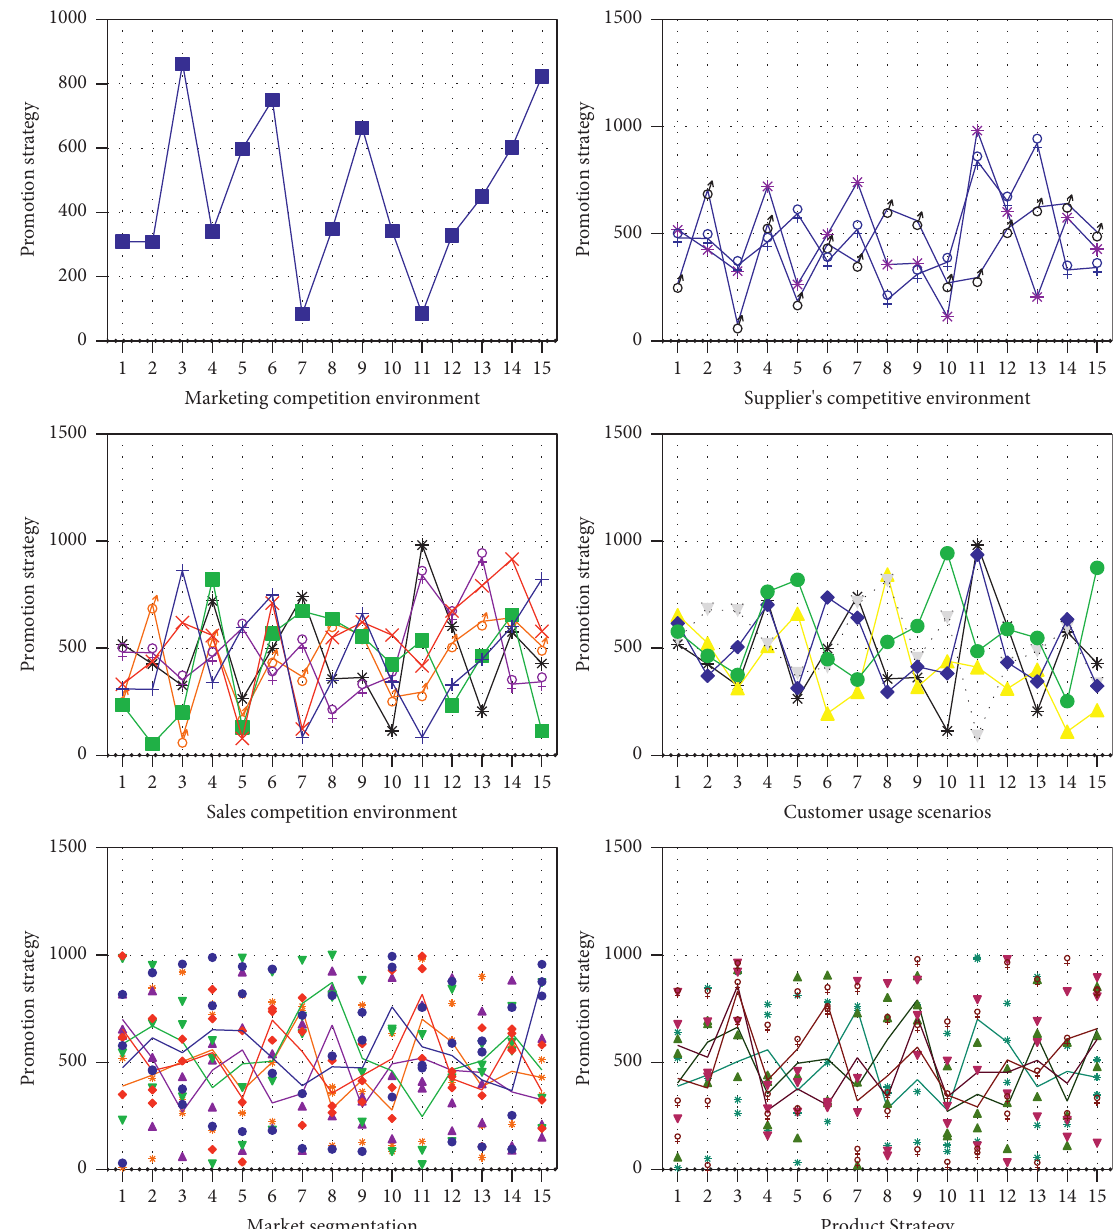
Figure 7: Service strategy classification effect under different grouping model